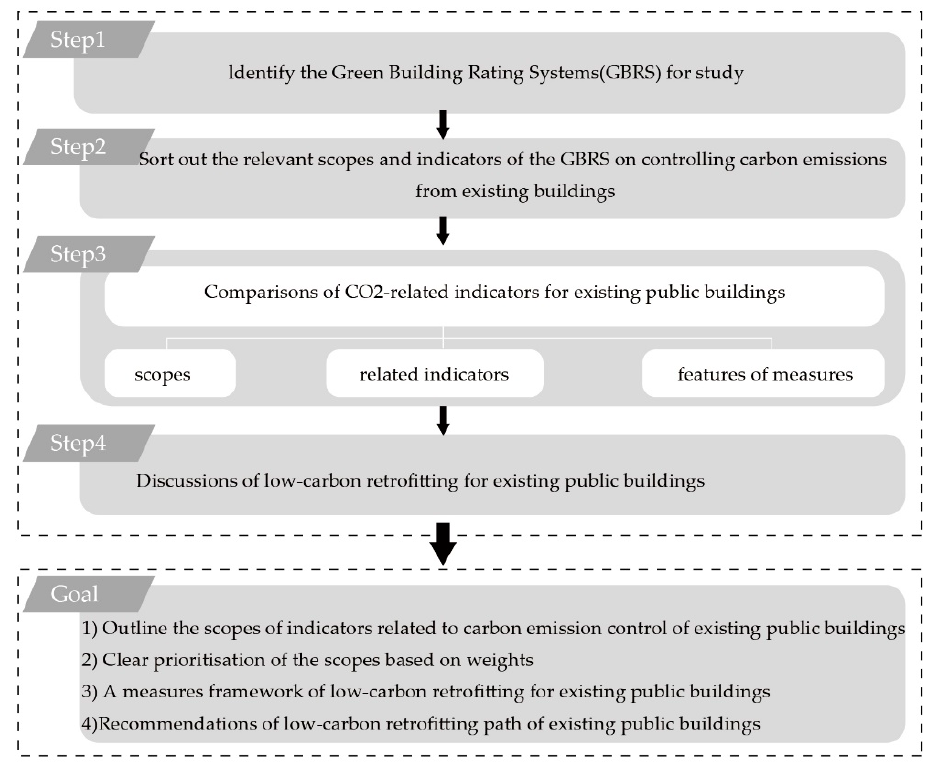
Figure 1. The study